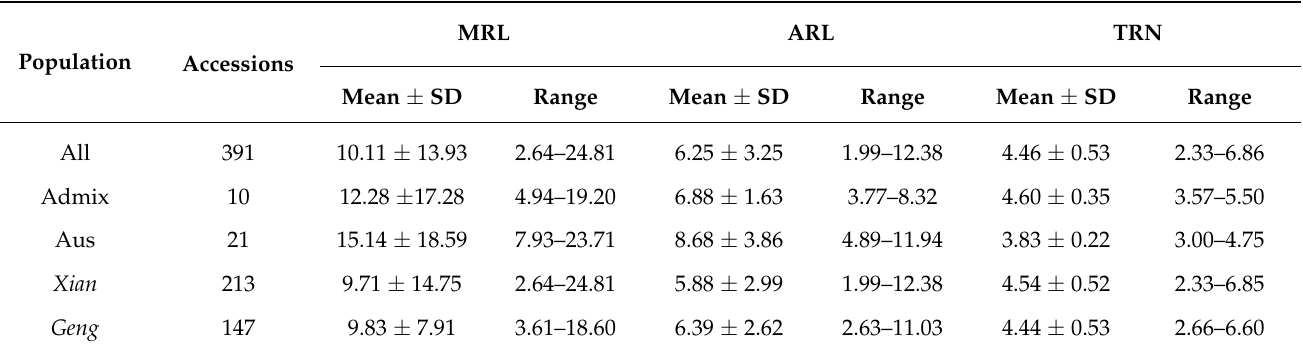
Table 1. Statistics of MRL, ARL, and TRN in different rice